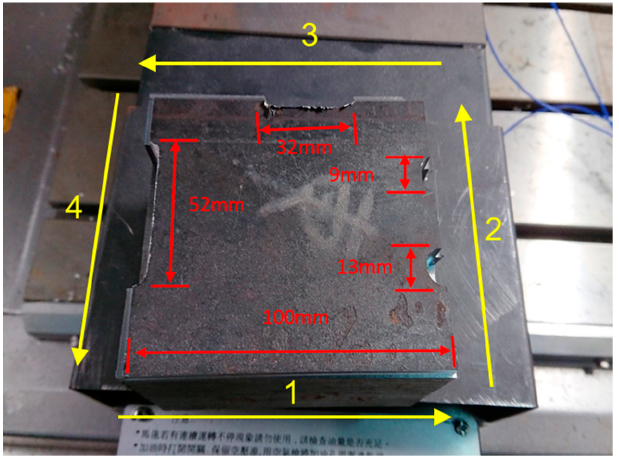
Figure 12. The sequence of cutting path for experiment 4 with empty groove.